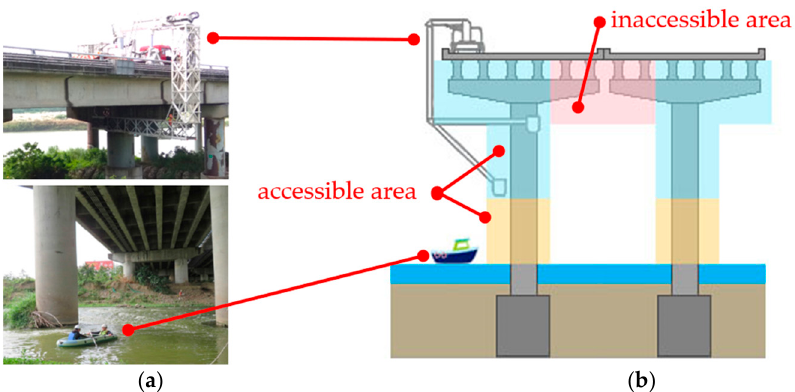
Figure 1. Traditional bridge inspection operations. ( a ) Bridge inspection equipment ( b ) Bridge inspection area.